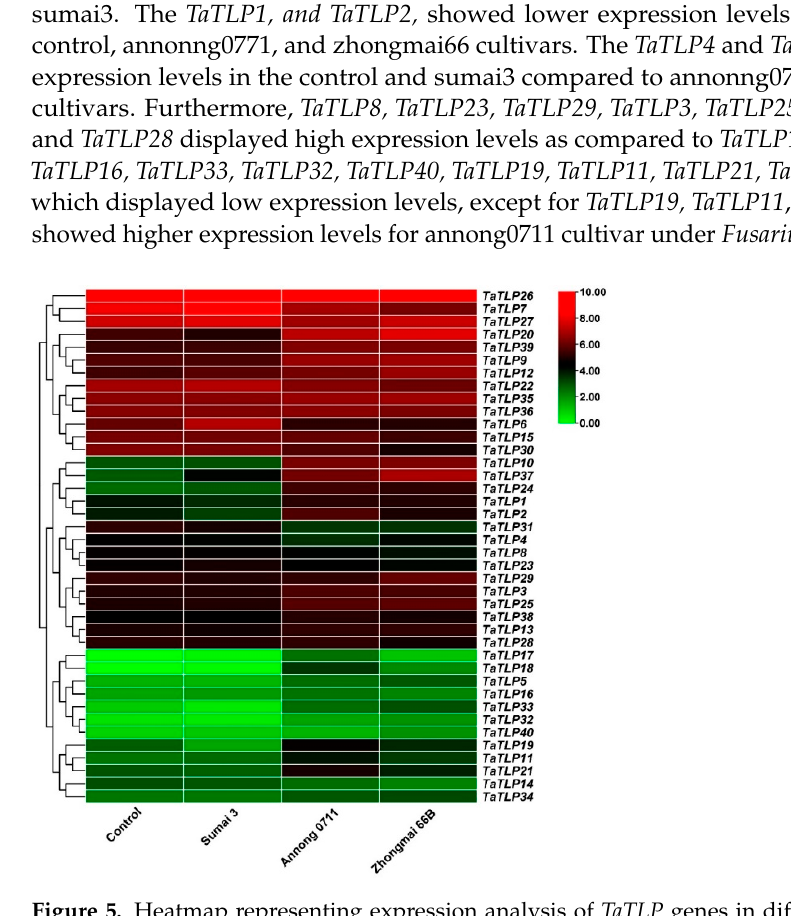
Figure 5. Heatmap representing expression analysis of TaTLP genes in different wheat cultivars subjected to Fusarium graminum stress.